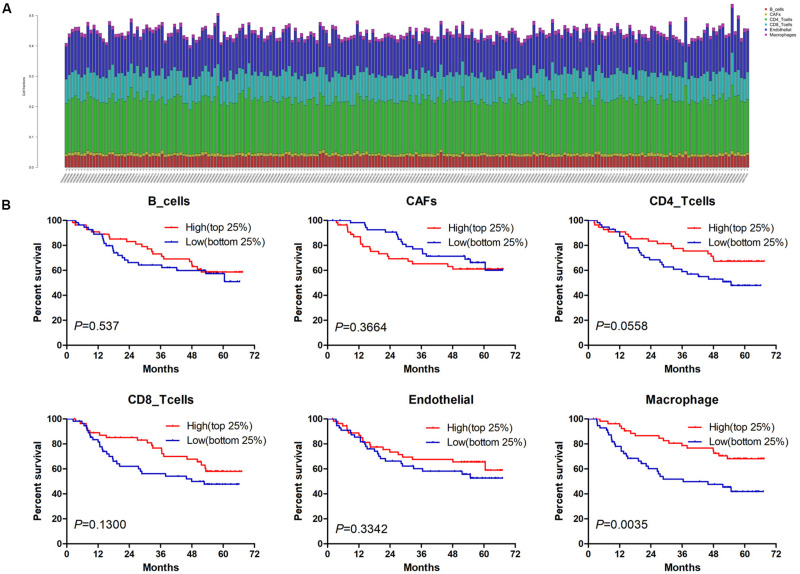
The prognostic value of six cell fractions in HCC patients from GSE14520. (A) The composition of six cell fractions in HCC patients (n = 221). (B) The OS analysis of HCC patients with top (n = 55) and bottom 25% (n = 56) infiltration levels of six cell fractions.